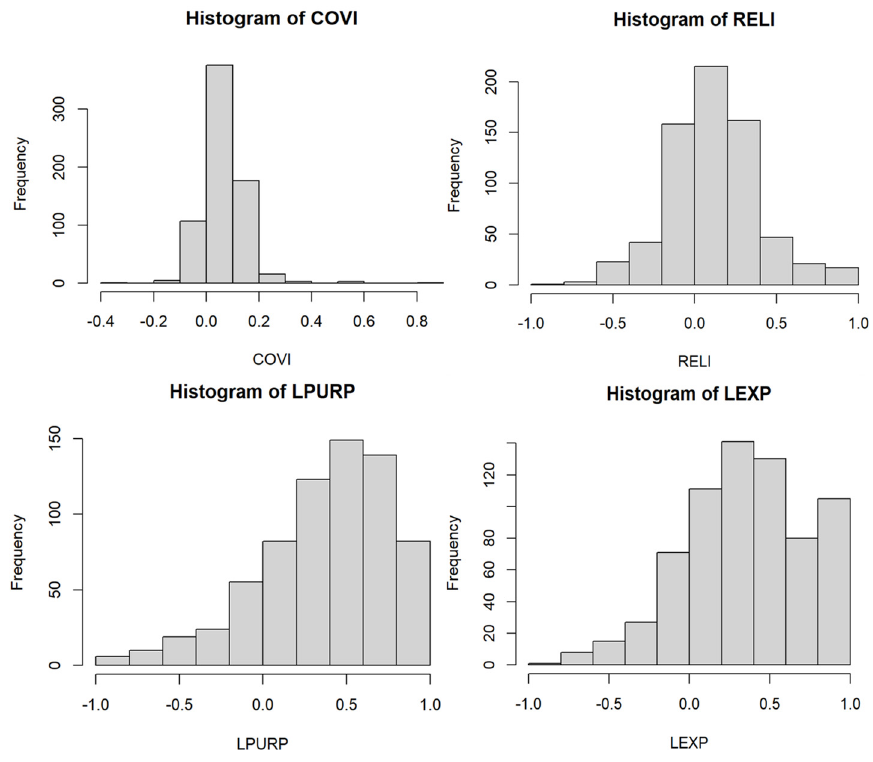
Figure 2. Histograms. Notes: The vertical axes represent the frequencies, and the horizontal axes represent the sentiment scores.